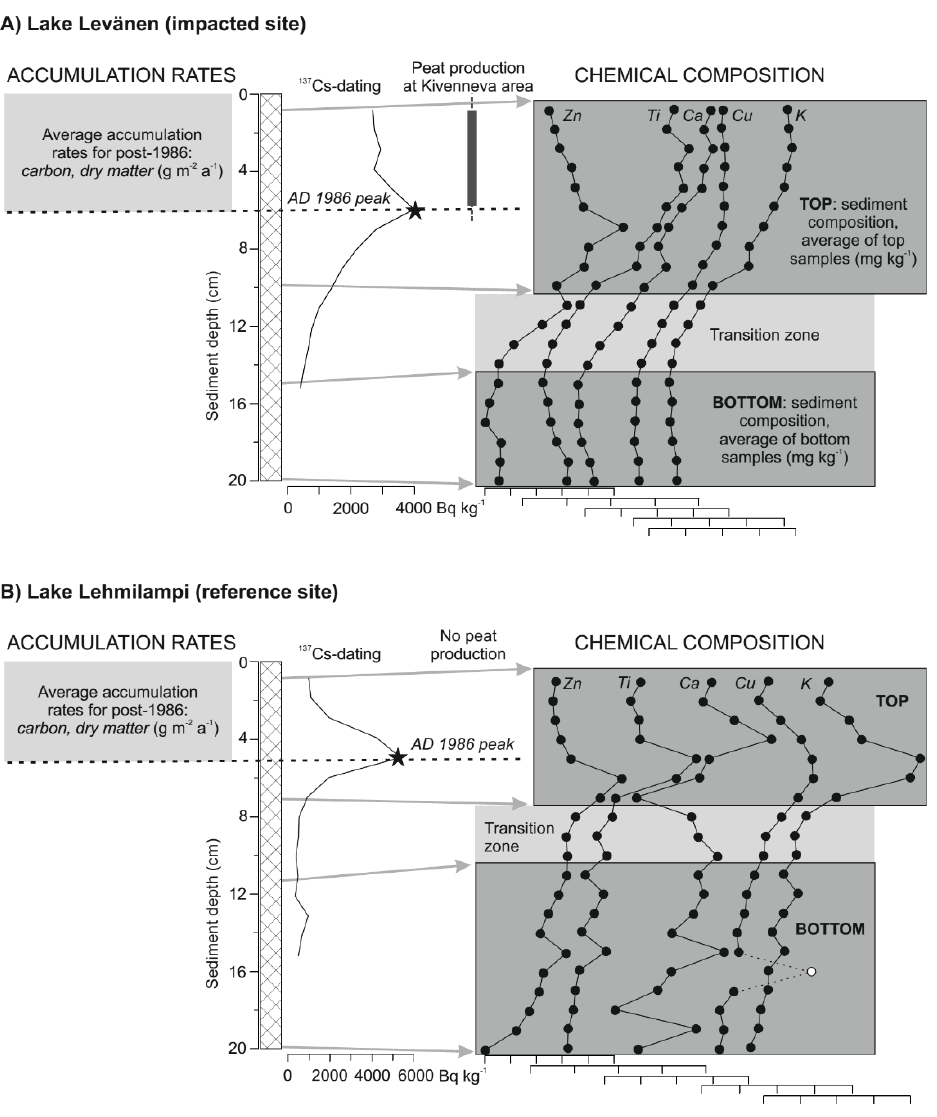
Figure 3. The accumulation rates were studied from the post-1986 sediment sections of the cores (left panel), whereas the top–bottom sediment sections were defined independently of the dating results based on the changes in element composition alone (right panel). ( A , B ) presents examples for impacted lake (( A ), Lake Levänen) and reference lake (( B ), Lake Lehmilampi).